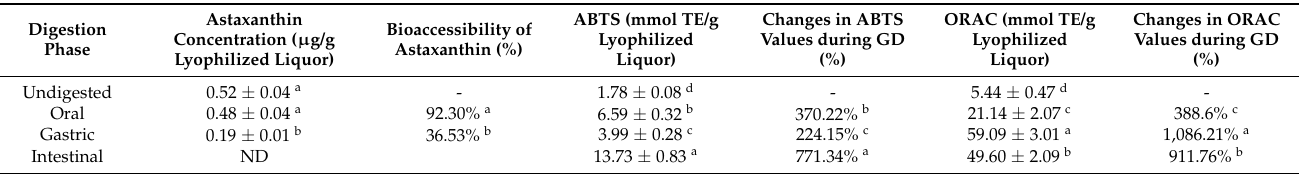
Table 3. Astaxanthin concentration by HPLC and antioxidant capacity (ABTS and ORAC assays) of optimized undigested and digested supercritical CO 2 extracts of lyophilized